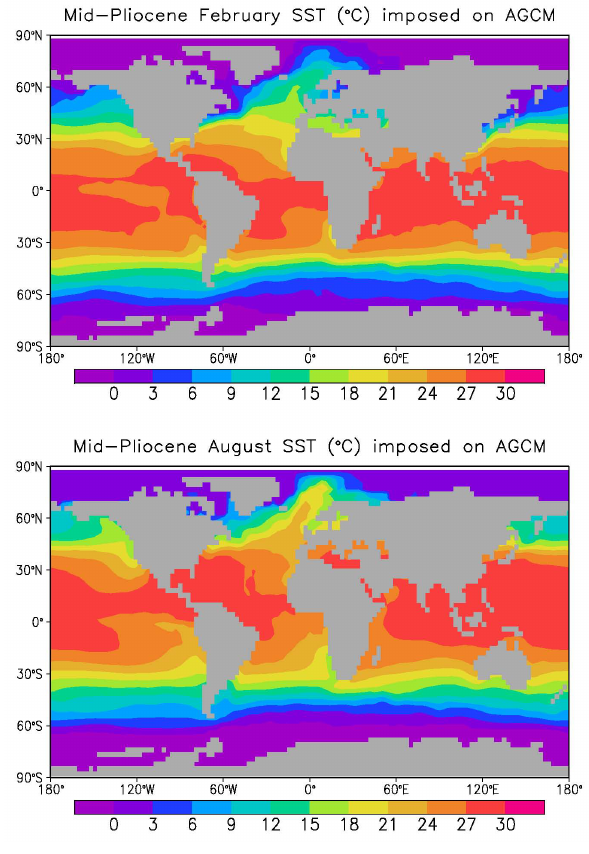
Fig. 4. Mid-Pliocene sea surface temperature imposed on the AGCM during February and